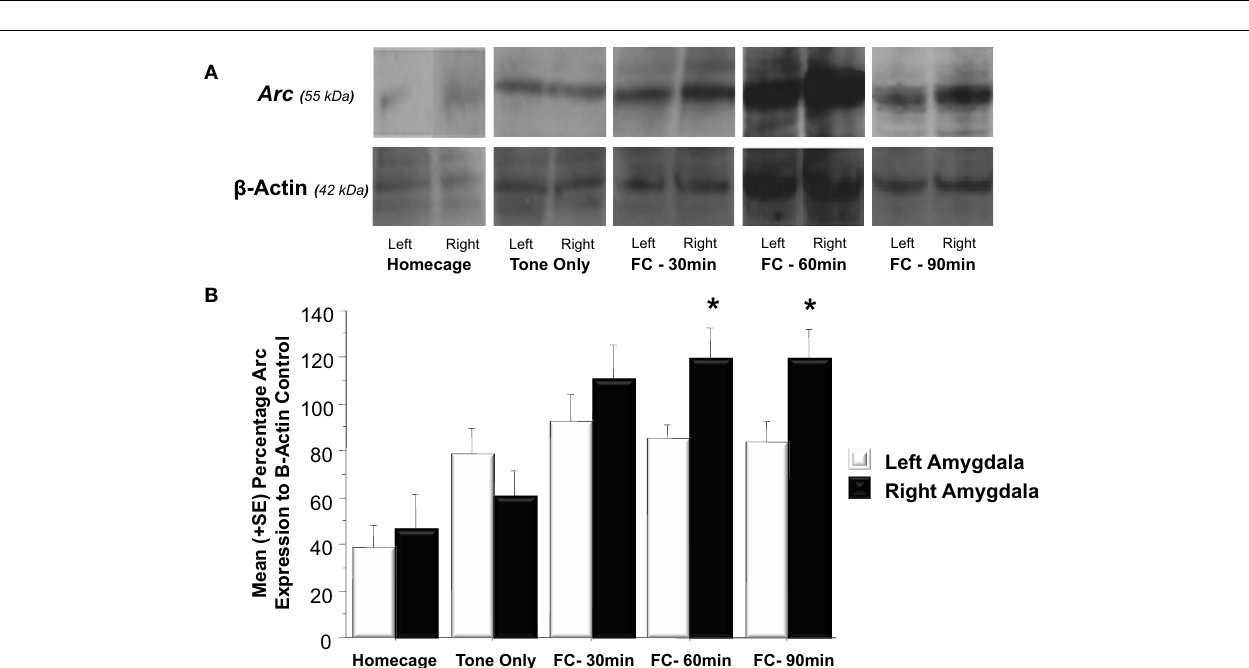
tone presentations than controls in the Tone Only Group (Fear Conditioning 30min vs. Tone Only, p < 0 . 01; Fear Conditioning 60min vs. Tone Only, p < 0 . 01; Fear Conditioning 90min vs. Tone Only, p < 0 . 01). ∗∗ p < 0 . 01.